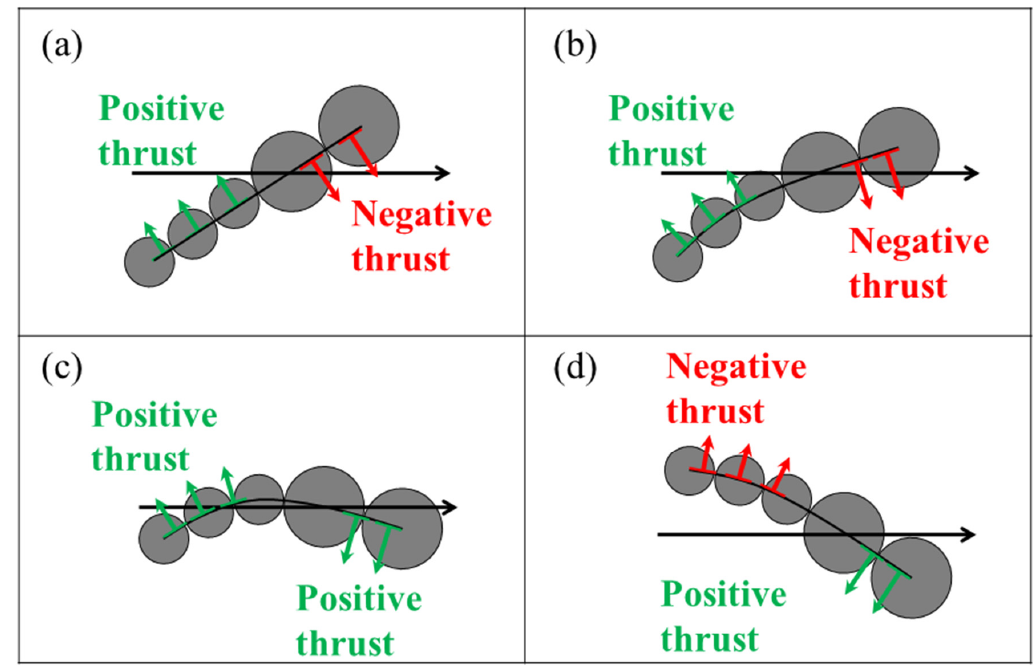
Figure 5. Schematic diagram of sequential images showing the direction of the thrust for the head and tail of a swimmer within the first half-period of oscillation. ( a ) Initial position. ( b ) The head and tail generate negative and positive thrust, respectively. ( c ) The head and tail simultaneously generate positive thrust. ( d ) The head and tail generate positive and negative thrust, respectively.